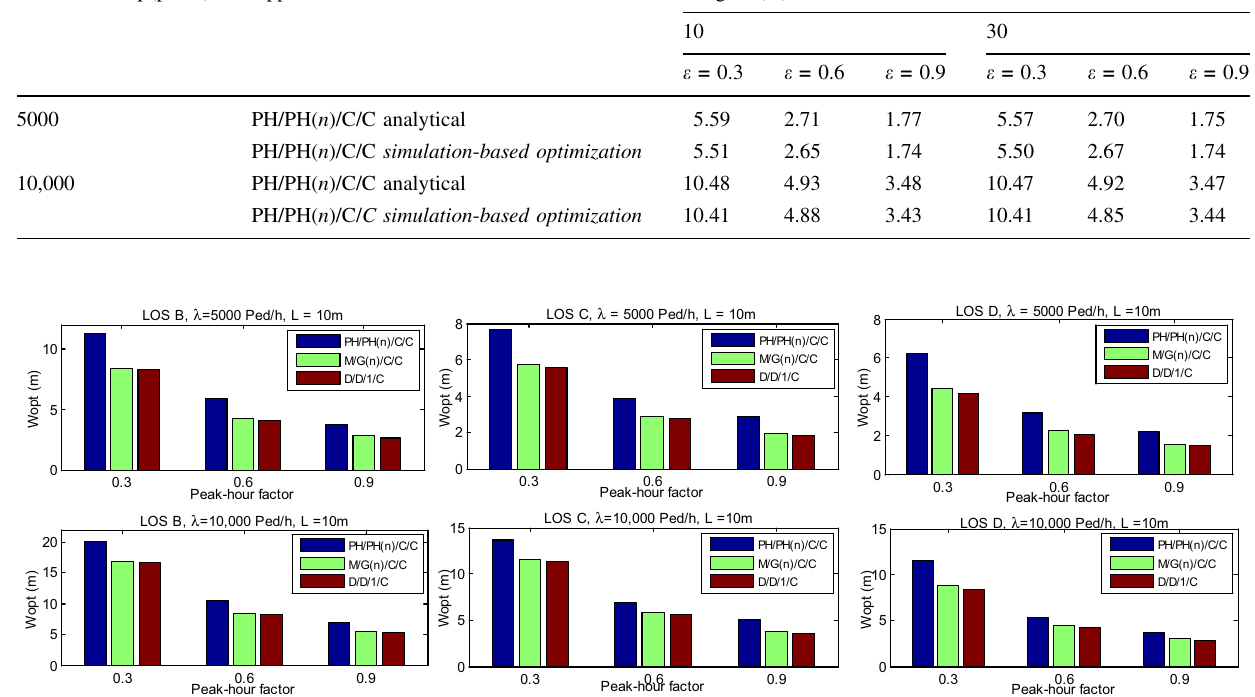
Table 5 Comparison of simulation - based optimization with analytical approach under LOS ‘D’ Arrival rates q (ped/h) Approaches